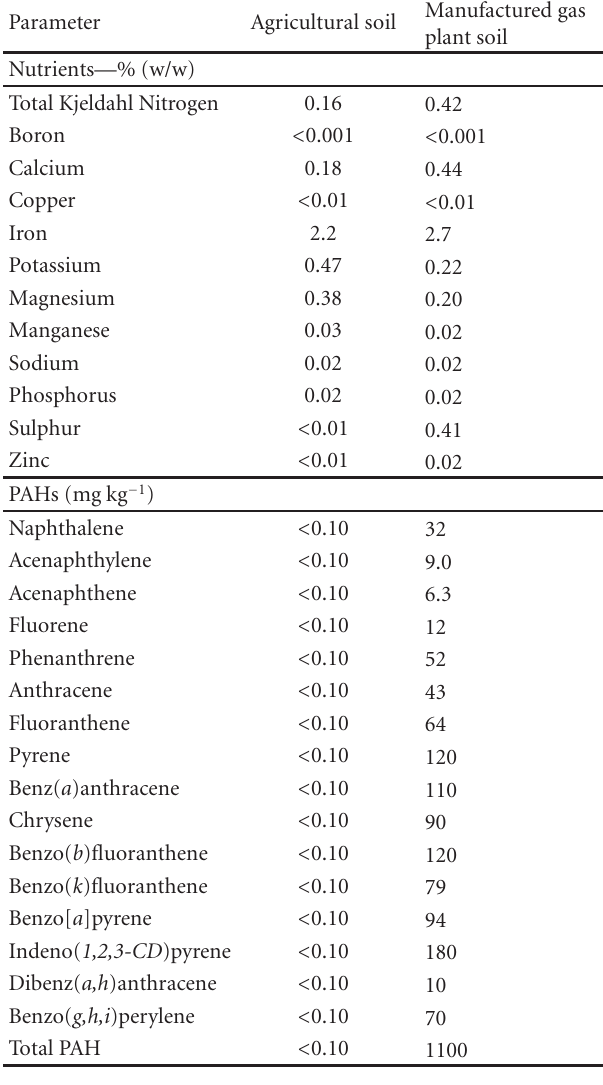
Table 1: Soil properties of manufacturing gas plant soil